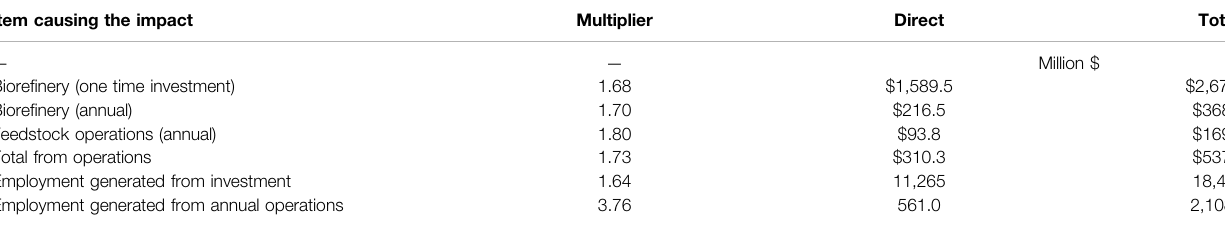
TABLE 11 | Total economic activity generated from the three biore fi neries. Item causing the impact